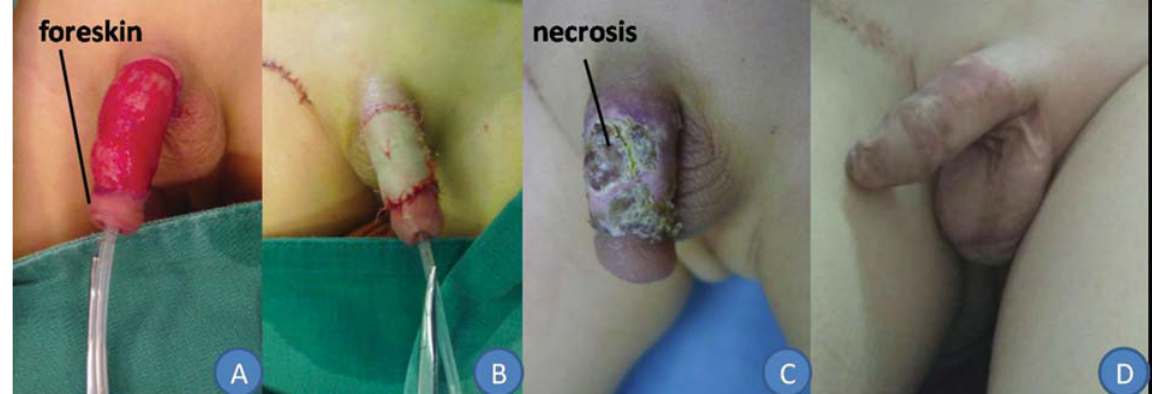
Fig. 1 A 4.11-year-old boy suffereda high fall-related penile injury and presented with tearing of the penile skin, loss of the penile shaft skin, and retention of the front of the foreskin ( A ). The boy received a full-thickness skin graft (FTSG) ( B ). The FTSG survived almost completely at 10 days after surgery, and the small area of skin necrosis healed after changing of the dressing ( C ). The scar was slightly hyperplastic and hyperpigmented 8 months after surgery ( D ).